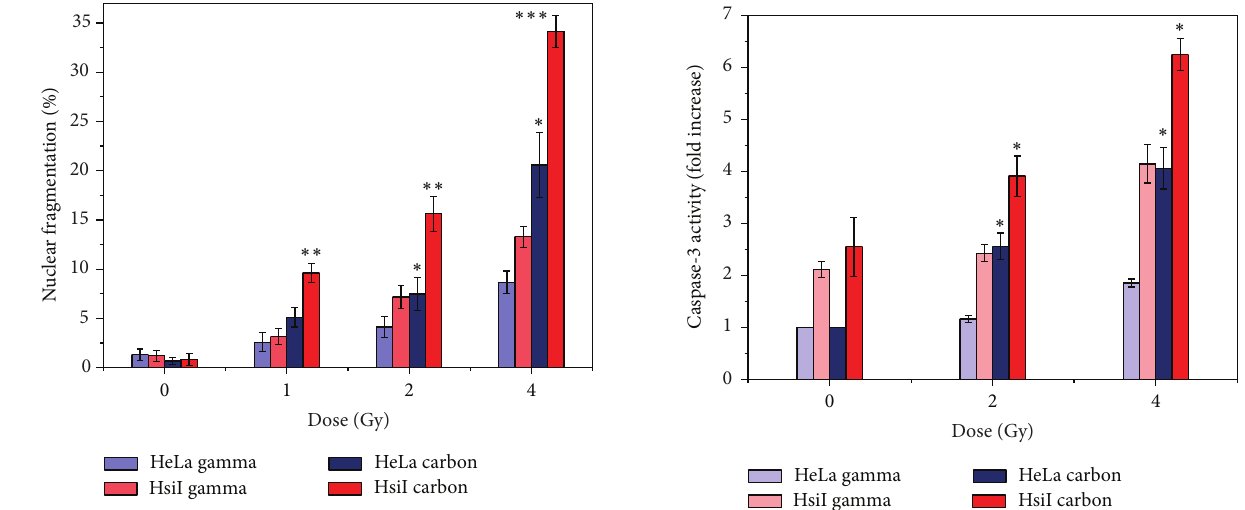
Figure 5: Caspase-3 activity in HeLa and HsiI cells irradiated with carbon ion beam and gamma radiation. Each histogram represents the mean of fold increase with respect to unirradiated control HeLa of 3 independent experiments with the standard deviations (vertical lines). The significance values were obtained in carbon ion beam comparedwithgammaradiationataparticulardoseineachcelltype and denoted as “ ∗ ” (0.01 < 𝑃 ≤ 0.05)